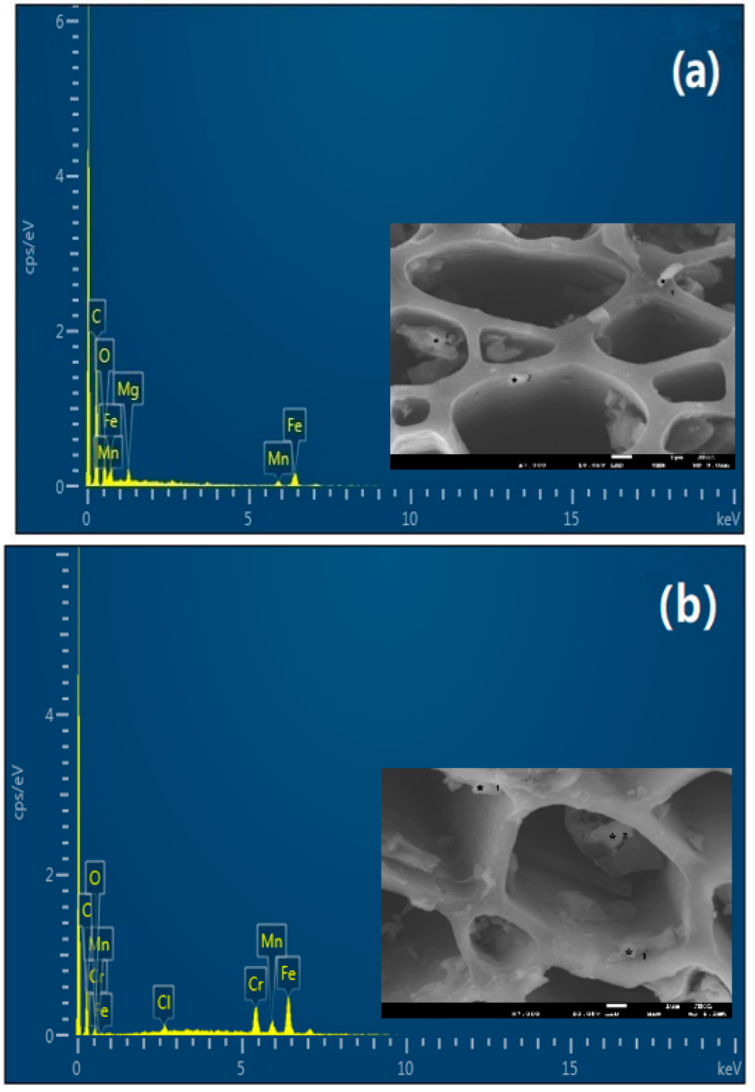
Figure 7. SEM-EDS spectrum of the FM-MBC. ( a ) FM-MBC, ( b ) FM-MBC after Cr(VI) adsorption. Thermodynamic Parameters